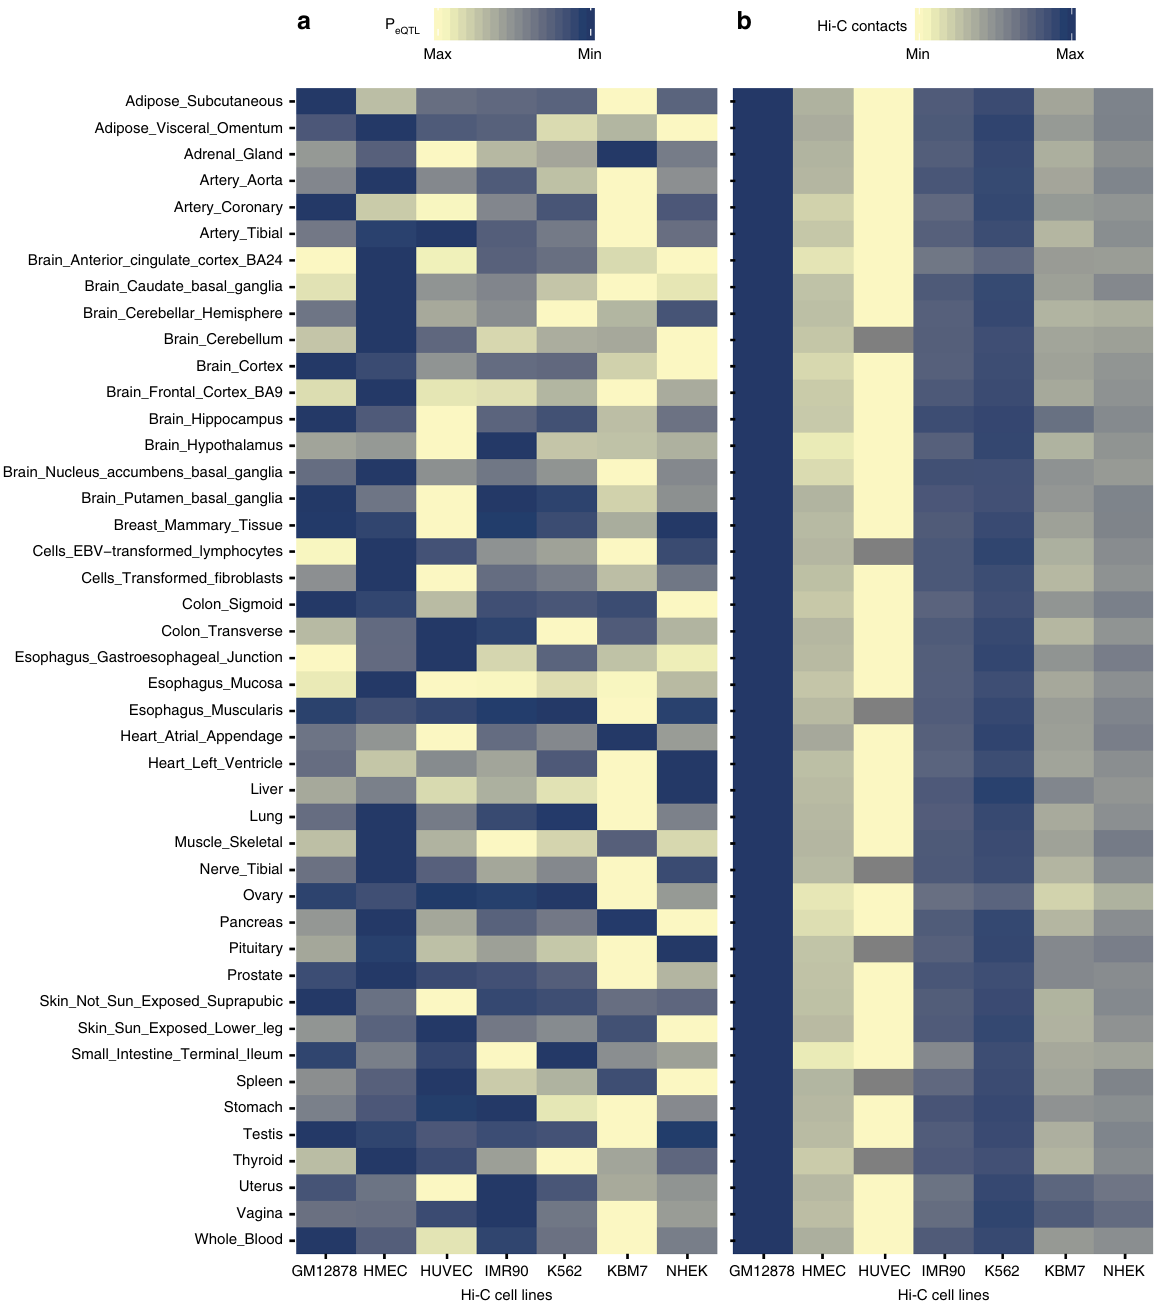
Fig. 5 Tissue and cell line-speci fi c effects of eQTLs. a eQTL effects are strong in Hi-C cell lines that represent the tissues that they are derived from. The heatmap shows the range of mean eQTL p -values in tissues, with the yellow and blue colours representing the Hi-C cell lines with the minimum and maximum mean eQTL p-values respectively. b The number of Hi-C contact counts between the regions containing the eQTL-eGene pairs show less tissue speci fi eQTL-eGene contact in cell lines are relatively uniform across tissues but the eQTL effects in the cell lines are tissue speci fi c. This is consistent with previous results that show that transcrip- tion is not necessary for the formation and maintenance of a spatial connection 40,41 .